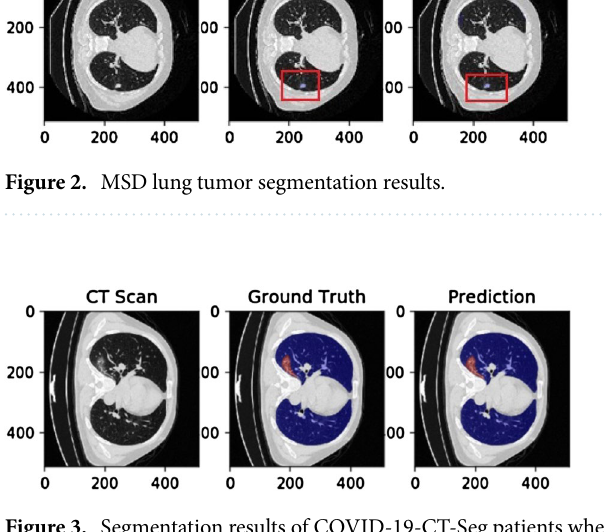
Figure 3. Segmentation results of COVID-19-CT-Seg patients when the number of slices is 139.